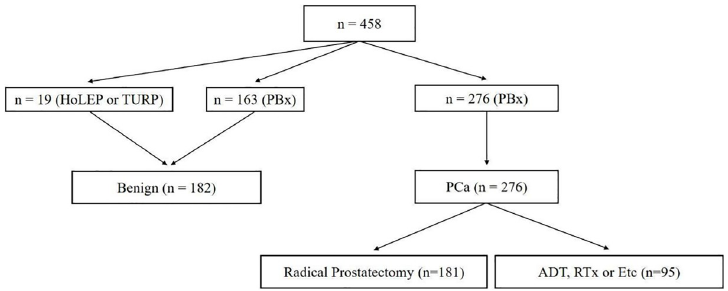
Fig 1. Study design. HoLEP, holmium laser enucleation of prostate; TURP, transurethral resection of prostate; PBx, prostate biopsy; PCa, prostate cancer; ADT, androgen deprivation therapy; RTx, radiation therapy.